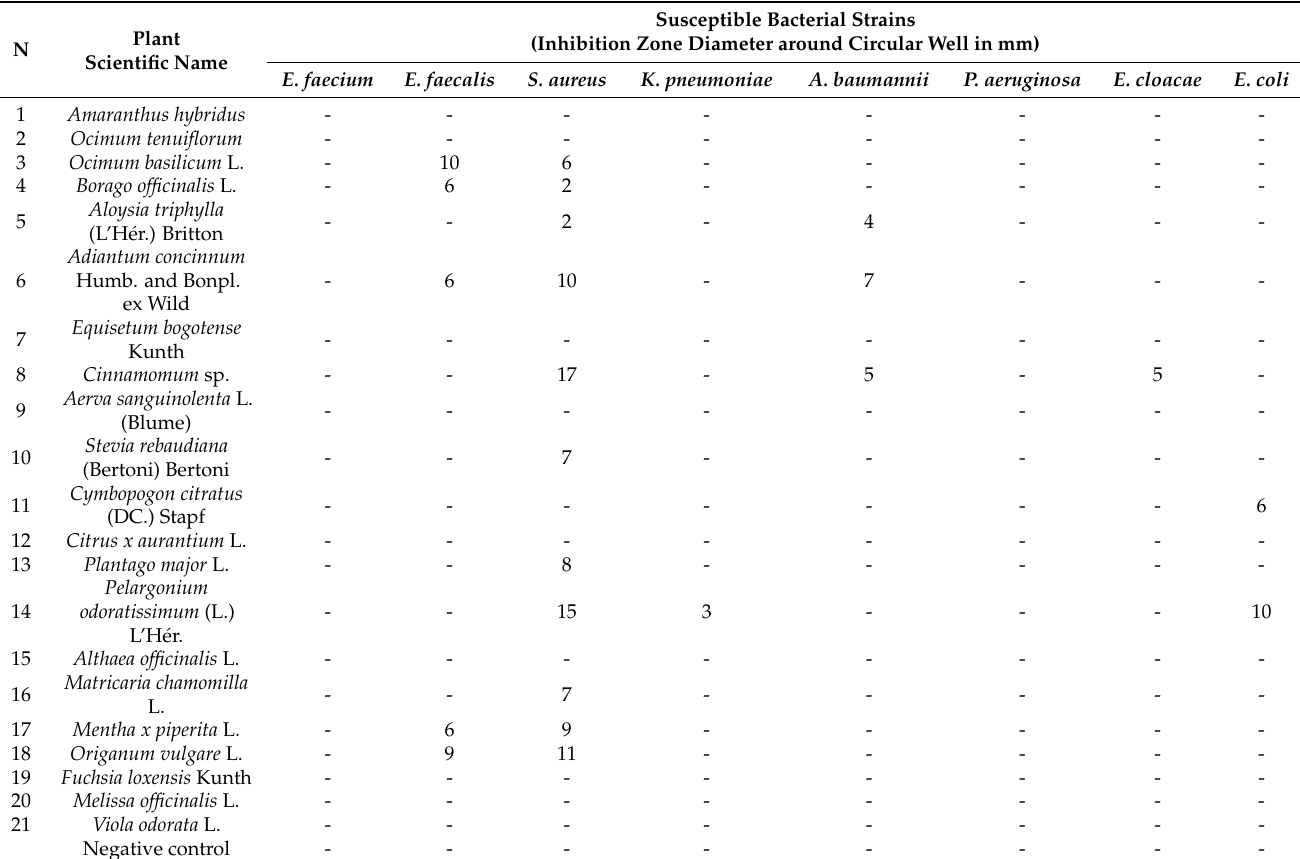
Table 2. Antibacterial activity of 21 crude plant extracts used in the herbal infusion horchata against susceptible bacterial strains of clinical importance determined by the well diffusion method.